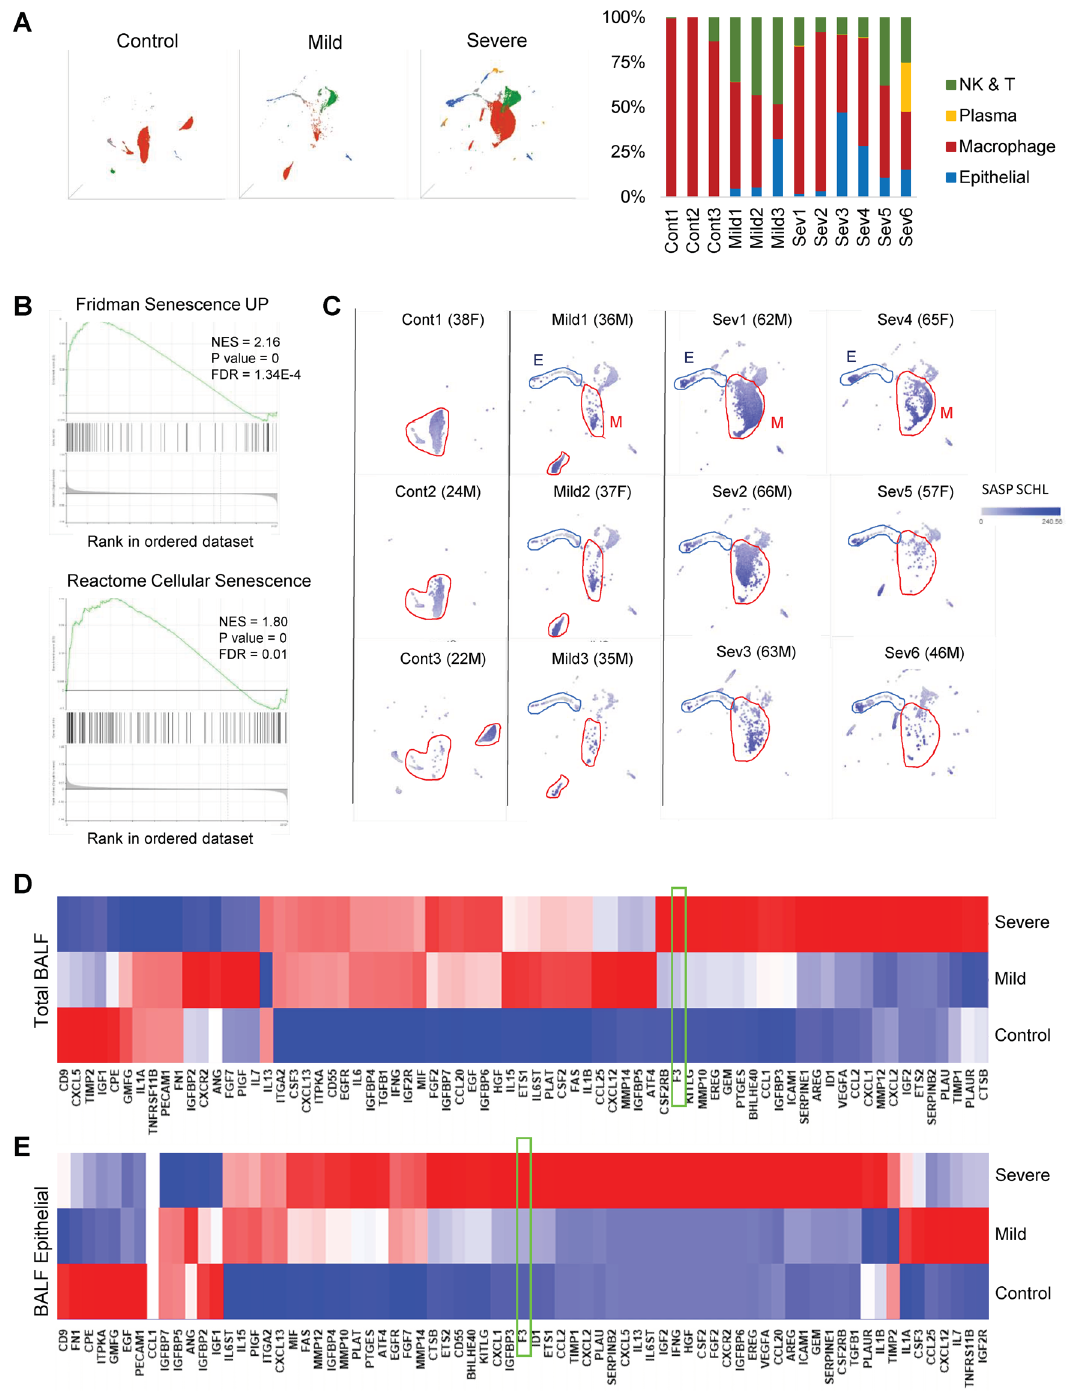
Figure 1. Senescence is a common response to COVID-19 infection. ( A ) UMAP projection of the major cell types in bronchoalveolar lavage fluid (BALF) cell population from healthy controls and COVID-19 patients (Control, n = 3; Mild, n = 3; Severe, n = 6). Each point represents a single cell. Major cell types were marked with different colors and quantitated per individual samples. ( B ) Representative GSEA plots of Reactome Cellular Senescence and Fridman Senescence UP gene sets. Positive normalized enrichment score (NES) indicates enrichment compared to the controls. ( C ) UMAP representation of BALF cell population from each COVID- 19 patient. Each gray point represents a single cell. Age and sex were listed next to sample name. SASP factor expression levels using the SASP Schleigh gene list 39 are marked with a blue color gradient. Prominent cell types are outlined and labeled. E = Epithelial cells and M = Macrophage. ( D ) Heat map plots of the SASP gene sets in BALF cells populations (Severe COVID patients: 41,323, Mild COVID patients: 8613, healthy control: 23,486 cells). ( E ) Heat map plots of the SASP gene sets in BALF epithelial cells (Severe: 2705, Mild: 551, healthy control: 72 cells). Note that F3 is not on the SASP SCHL list but added for comparison (boxed in